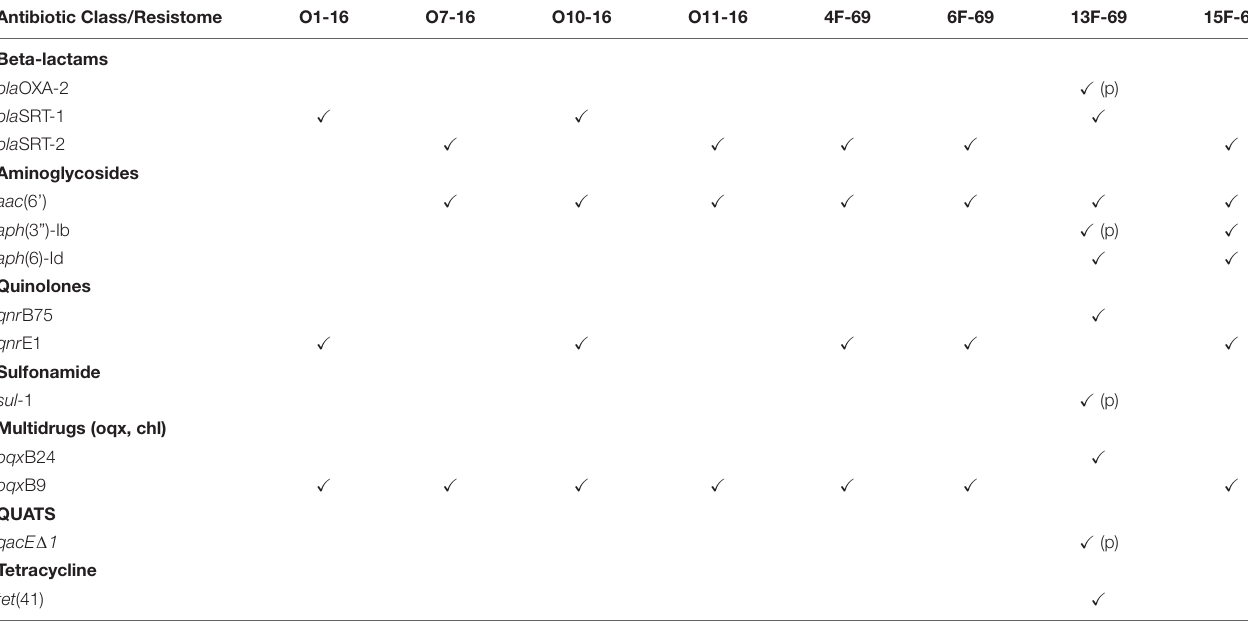
TABLE 4 | Resistome derived from WGS analysis of the eight Serratia marcescens isolates of the study and major antibiotic classes which can be potential targets of the products the resistance genes encode. Antibiotic Class/Resistome